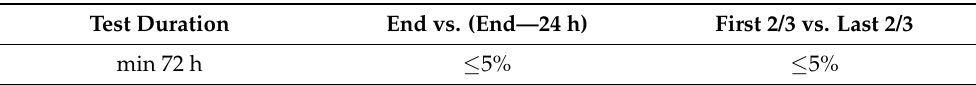
Table 1. Acceptance criteria defined by standard ISO 9869-1 [22] for ensuring the U -value converges to an asymptotical